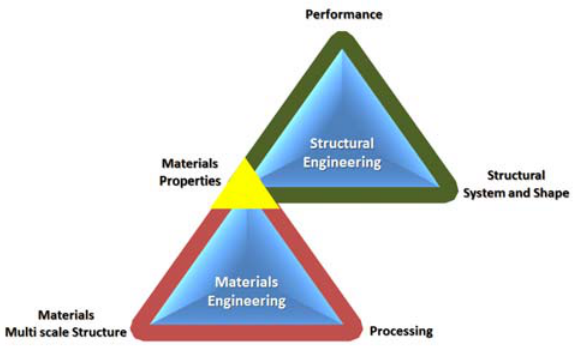
Figure 3. Schematic diagram of Integrated Structures and Materials Design (Based on